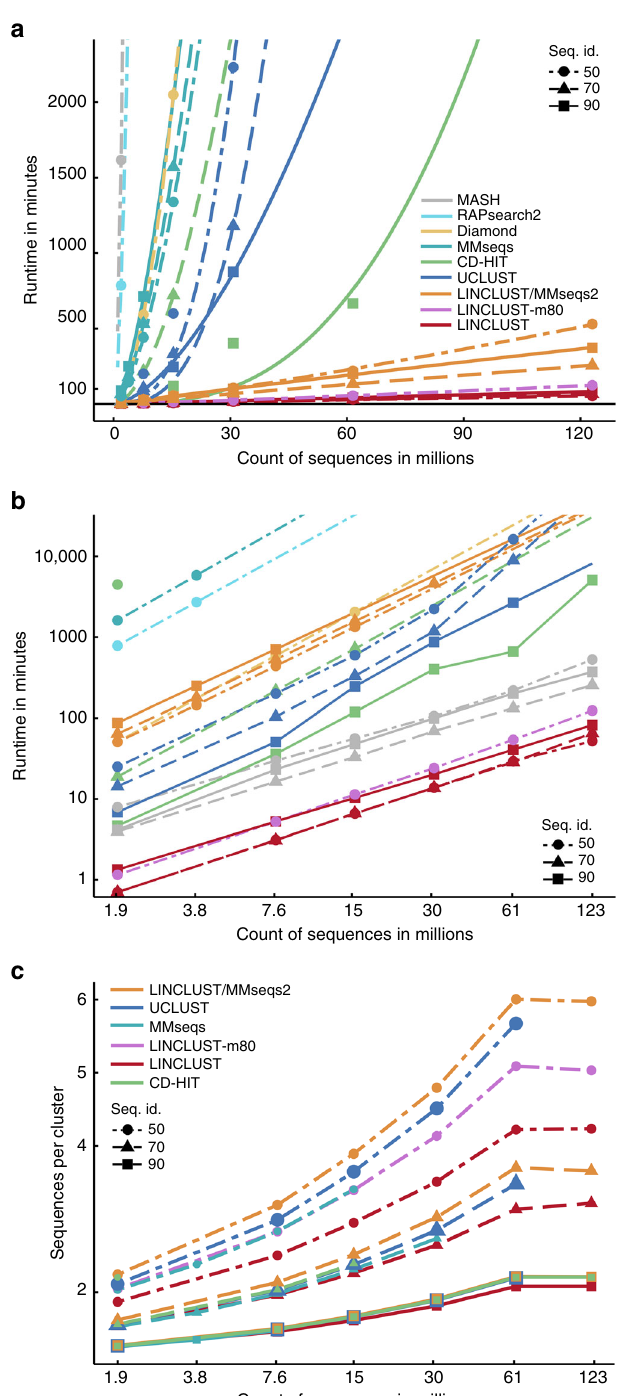
Fig. 2 Linclust and Linclust/MMseqs2 manifest unique linear scaling of runtime with sequence set size. a Runtime versus input set size on linear scales. The plotting symbols indicate the sequence identity threshold for clustering of 90%, 70%, and 50%. The curves are fi ts with a power law, bN a . For comparison, we include runtimes of all-against-all searches using sequence search tools DIAMOND, RAPsearch2, and MASH. Runtimes were measured on a server with two Intel Xeon E5-2640v3 8-core CPUs and 128 GB RAM. b Same as ( a ) but on log-log scales. c Average number of sequences per cluster at 90%, 70%, and 50% sequence identity. Larger average cluster sizes imply higher sensitivities to detect similar